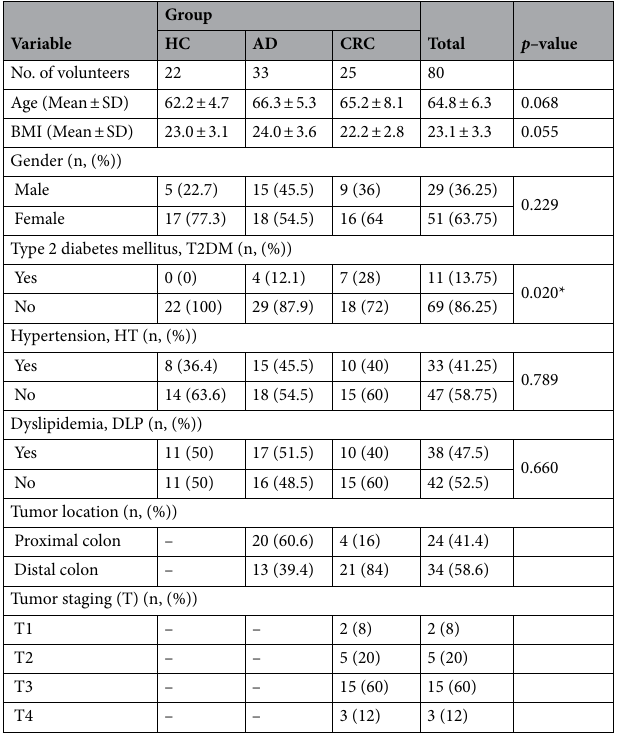
Table 1. Demographic and clinical data of the participants in this study. Statistical significance was determined by the nonparametric Kruskal–Wallis test. Gender and underlying diseases were evaluated with the chi–squared test. Data are shown as mean ± SD. HC healthy control; AD patients with adenomas; CRC patients with colorectal cancer. * p <